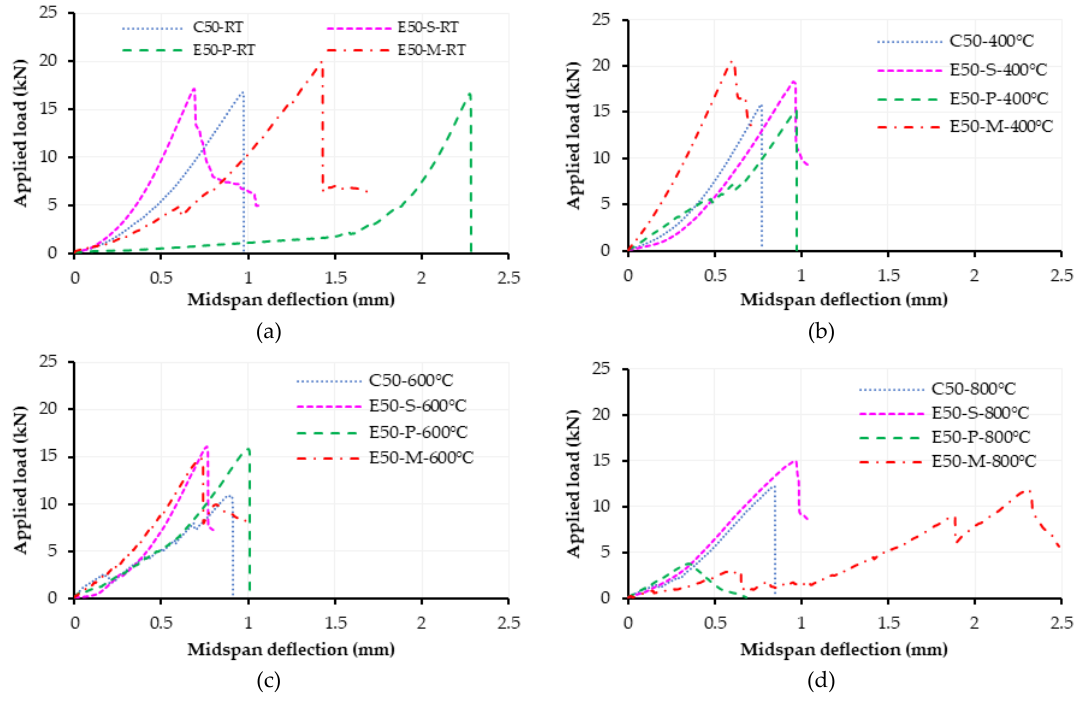
Figure 13. Load – deflection curves of medium-strength LWC specimens: ( a ) room temperature, ( b ) 400 °C, ( c ) 600 °C, and ( d ) 800